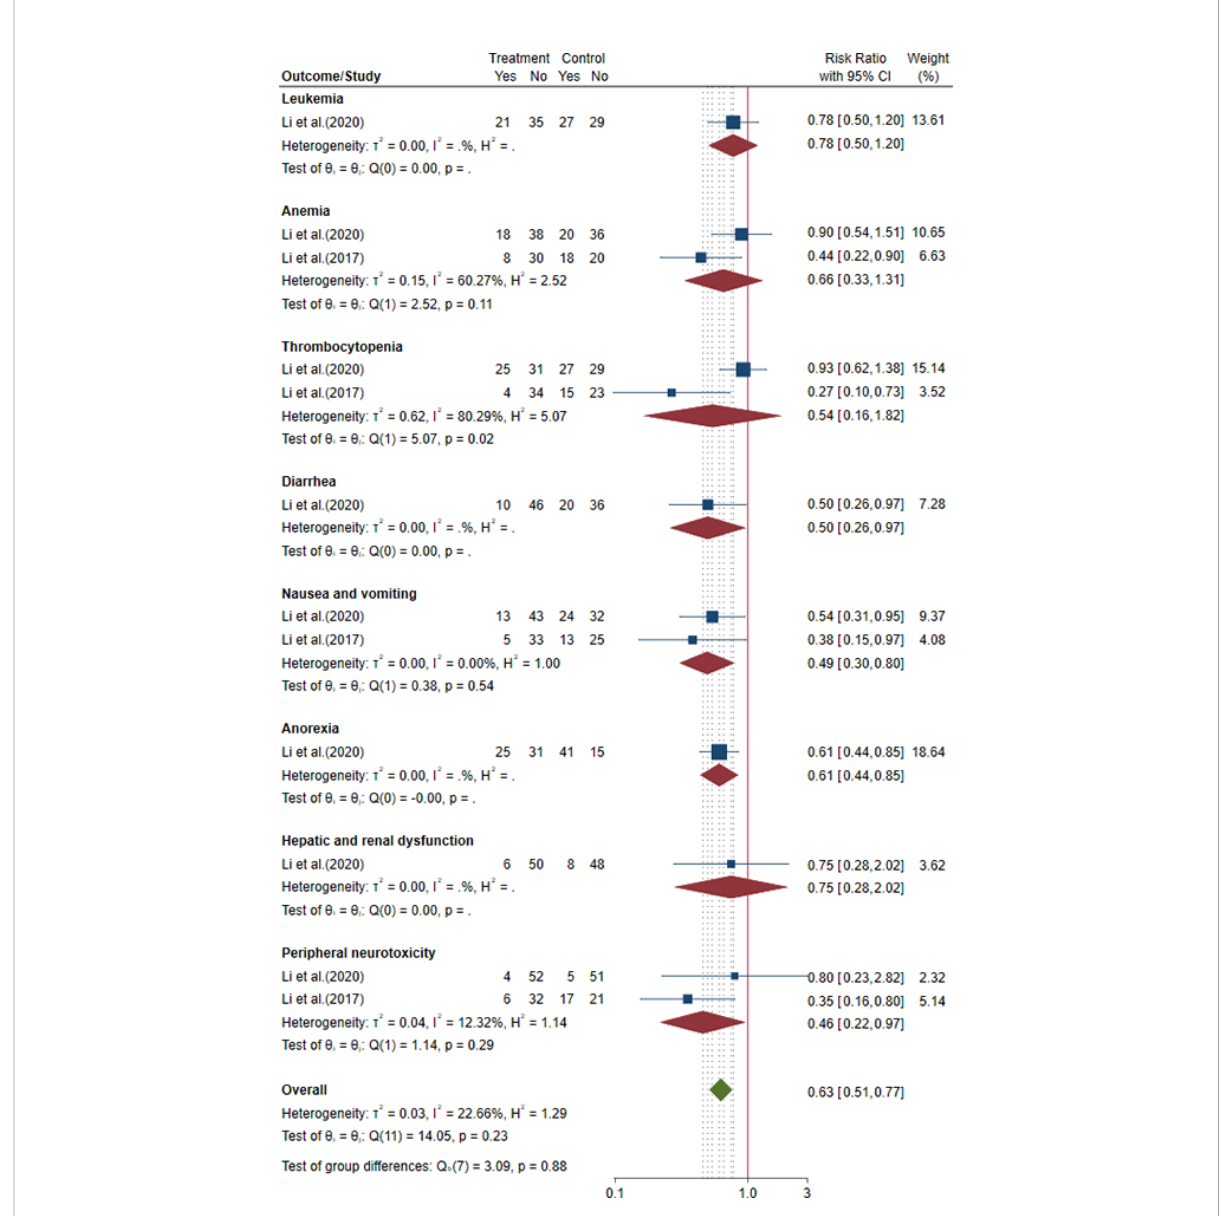
FIGURE 5 Forest plot of adverse events (AEs) in postoperative gastric cancer